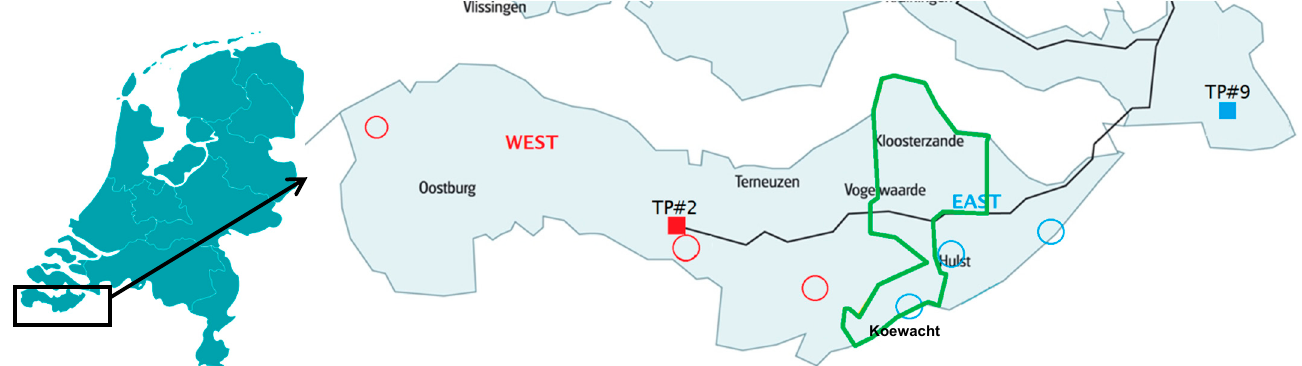
Figure 1. Location of Evides treatment plants (TP#2 and TP#9) and DWDS Zeeuws-Vlaanderen. Location of flush samples in DWDS Zeeuws-Vlaanderen West ( ) and East ( ). : indication of mixing area for TP#9 and TP#2 in the eastern section of Zeeuws-Vlaanderen until